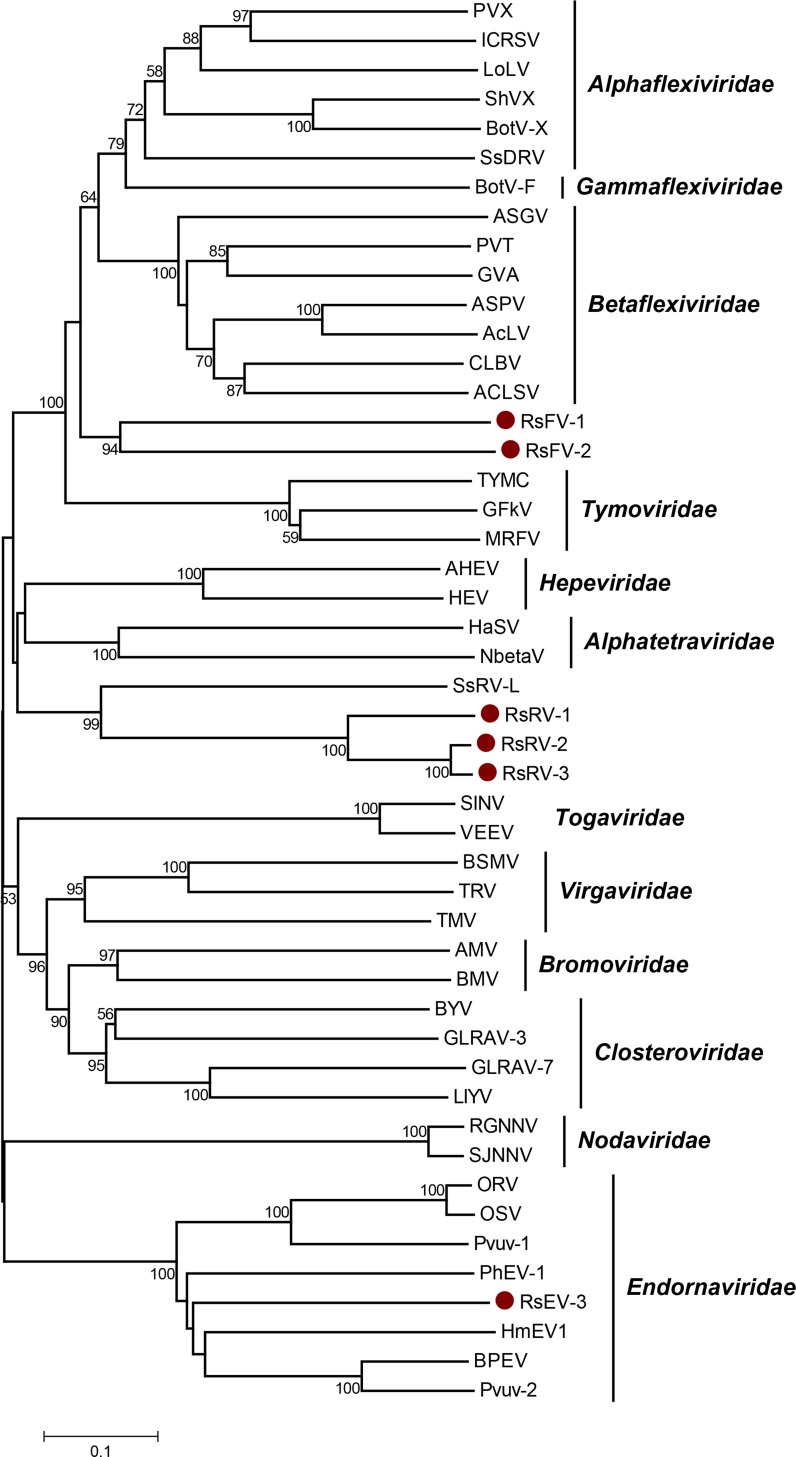
Phylogenetic analysis of selected type species within the families of the Alphavirus-like superfamily.An unrooted phylogenetic tree of the alphavirus-like superfamily was calculated based on the alignment of the RdRp domain spanning the conserved motifs A to G using the neighbor-joining method with 1000 bootstrap replicates. The scale represents a genetic distance of 0.1 amino acid substitutions per site. Bootstrap values < 50% are not shown. Newly identified species are marked with dots and compared to their next relatives and selected type species within families proposed to form the alphavirus-like superfamily [8, 29]. Analysis was conducted using MEGA 6.06 and the sequence alignment algorithm MUSCLE [45]. BPEV, Bell pepper endornavirus (AKP92841.1); ORV, Oryza rufipogon endornavirus (YP_438202.1); OSV, Oryza sativa endornavirus (YP_438200.1); PhEV-1, Phytophthora endornavirus 1 (YP_241110.1); Pvuv-1, Phaseolus vulgaris endornavirus 1 (YP_009011062.1); Pvuv-1, Phaseolus vulgaris endornavirus 2 (ALJ56098.1); SsRV-L, Sclerotinia sclerotiorum RNA virus L (ACE88957.1); ACLSV, Apple chlorotic leaf spot virus (ABY71563.1); AcLV, Aconitum latent virus (NP_116487.1); ASGV, Apple stem grooving virus (BAA98054.1); ASPV, Apple stem pitting virus (AEP02955.1); BotV-F, Botrytis virus F (NP_068549.1); BotV-X, Botrytis virus X (NP_932306.1); CLBV, Citrus leaf blotch virus (NP_624333.1); GFkV, Grapevine fleck virus (NP_542612.1); GVA, Grapevine virus A (AAO17778.1); ICRSV, Indian citrus ringspot virus (NP_203553.1); LoLV, Lolium latent virus (YP_001718499.1); MRFV, Maize rayado fino virus (NP_115454.1); PVT, Potato virus T (BAM16482.1); PVX, Potato virus X (AAF89747.1); SsDRV, Sclerotinia sclerotiorum debilitation-associated RNA virus (YP_325662.1); ShVX, Shallot virus X (NP_620648.1); BMV, Brome mosaic virus (NP_041197.1); AMV, Alfalfa mosaic virus (YP_053235.1); GLRAV-3, Grapevine leafroll-associated virus 3 (NP_813795.3); BYV, Beet yellows virus (NP_733949.1); LIYV, Lettuce infectious yellows virus (Q83045.2); GLRAV-7, Grapevine leafroll-associated virus 7 (YP_004935919.1); HCV, Hepatitis C virus (ALB38672.1); BVDV-1, Bovine viral diarrhea virus 1 (BAC55961.1); JEV, Japanese encephalitis virus (AEV57608.1); HEV, Hepatitis E virus (ALM55661.1); AHEV, Avian hepatitis E virus (AAL13366.1); SJNNV, Striped Jack nervous necrosis virus (NP_599247.1); RGNNV, Redspotted grouper nervous necrosis virus (ACV07658.1); SINV, Sindbis virus (AGT56188.1); VEEV, Venezuelan equine encephalitis virus (AAM28636.1); TBSV, Tomato bushy stunt virus (ACT67403.1); TNV-A, Tobacco necrosis virus A (ADE10194.1); TMV, Tobacco mosaic virus (AIL54434.1); TRV, Tobacco rattle virus (AHG52750.1); BSMV, Barley stripe mosaic virus (NP_604481.1); RsEV-3, Rhizoctonia solani endornavirus 3 (KX349065); RsFV-1, Rhizoctonia solani flexivirus 1 (KX349064); RsFV-2, Rhizoctonia solani flexivirus 2 (KX349069), RsRV-1, Rhizoctonia solani RNA virus 1 (KX349068); RsRV-2, Rhizoctonia solani RNA virus 2 (KX349067); RsRV-3, Rhizoctonia solani RNA virus 3 (KX349066).